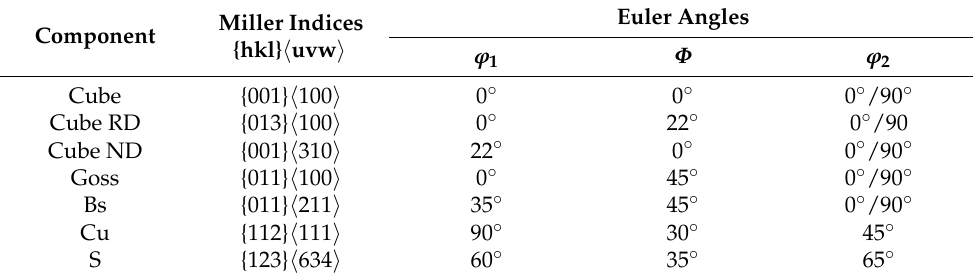
Table 1. Euler angles of ideal texture components including “ β -fiber” [12].